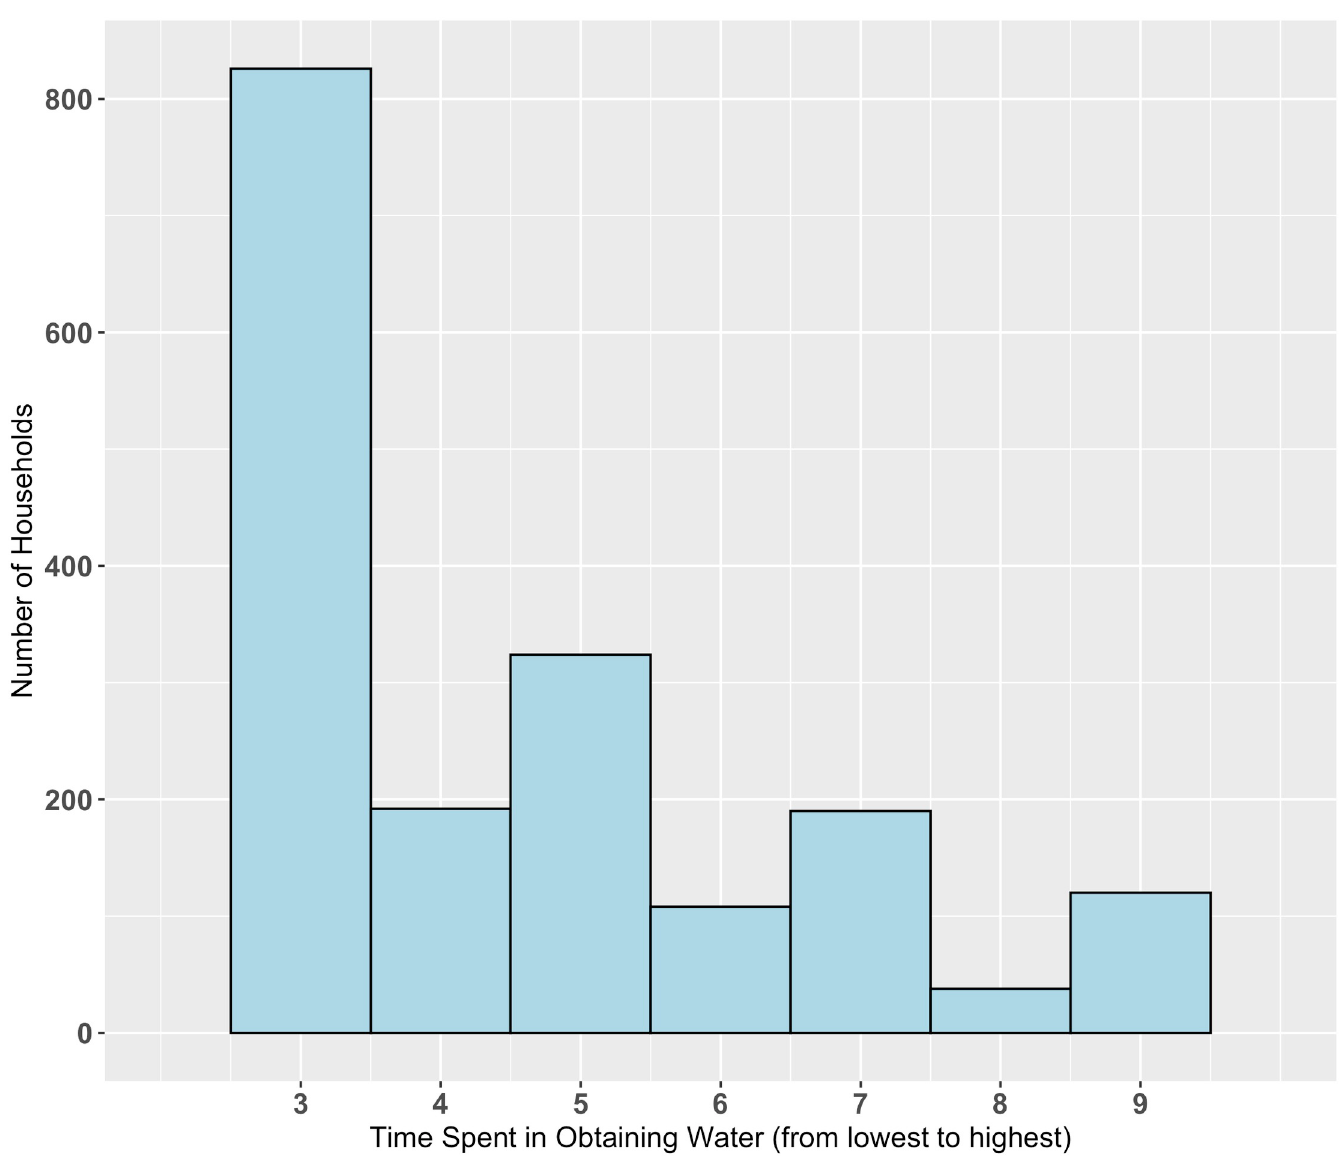
Fig 1. Distribution of total time spent obtaining water as a composite variable (no units). Total time spent obtaining water = one-way travel time x 2 + wait time, 1 for one-way travel time if < 30 minutes, 2 if 30 minutes– 1 hour, 3 if > 1 hour, with similar numerical assignments for wait time. For example, if time spent obtaining water = 9, the household was more than one hour’s walk from the water source and had to wait more than one hour for water once at the water source.